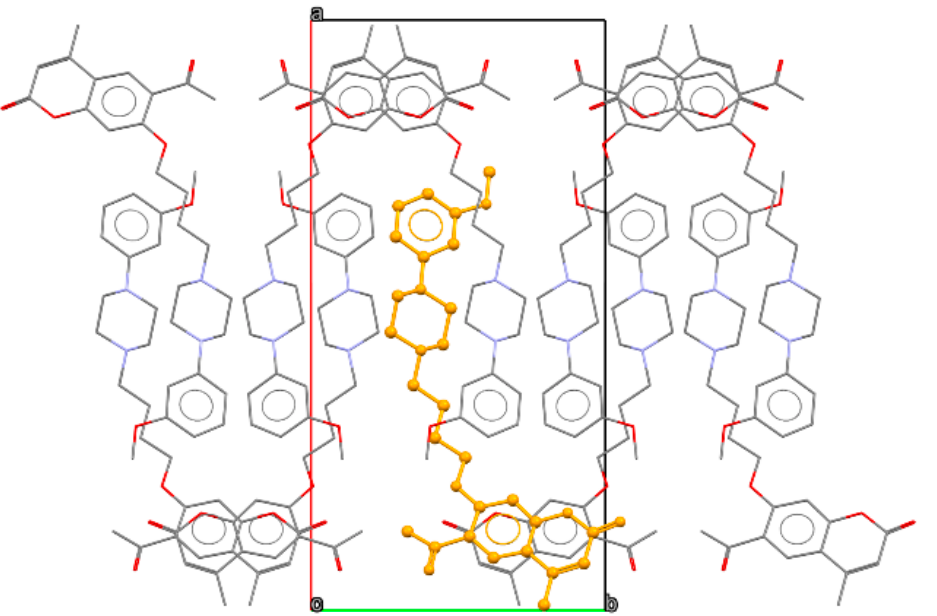
Figure 3. Packing diagram of 2 , view along the [001] direction. Orange color indicates single molecule, oxygen atoms are shown in red, nitrogen in blue, carbon in grey.